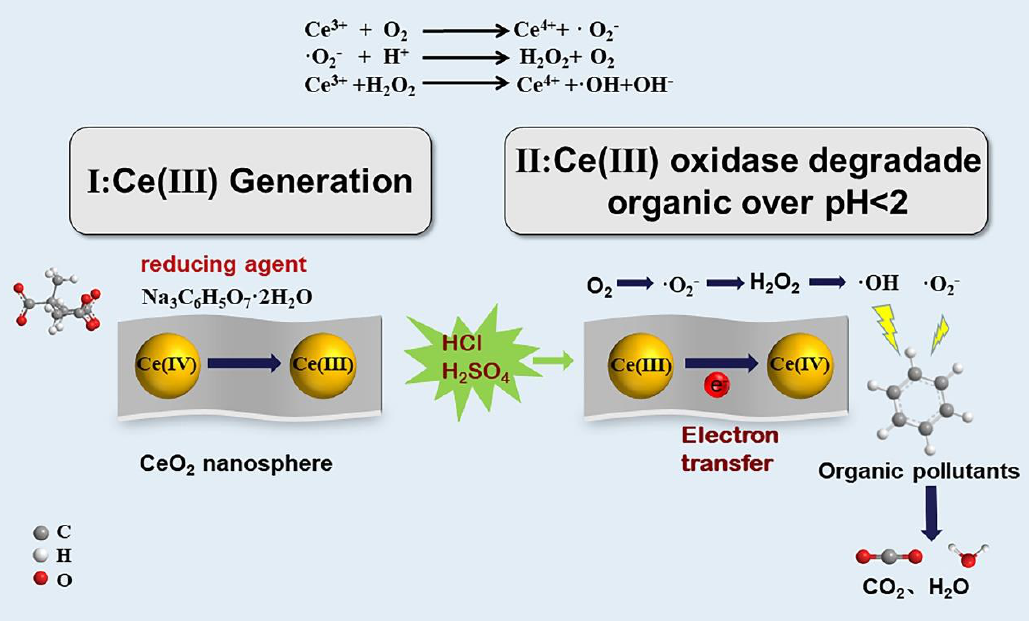
Figure 5. Schematic diagram of mechanism CeAY oxidizes organic in low pH and decomposition into H 2 O and CO 2 .